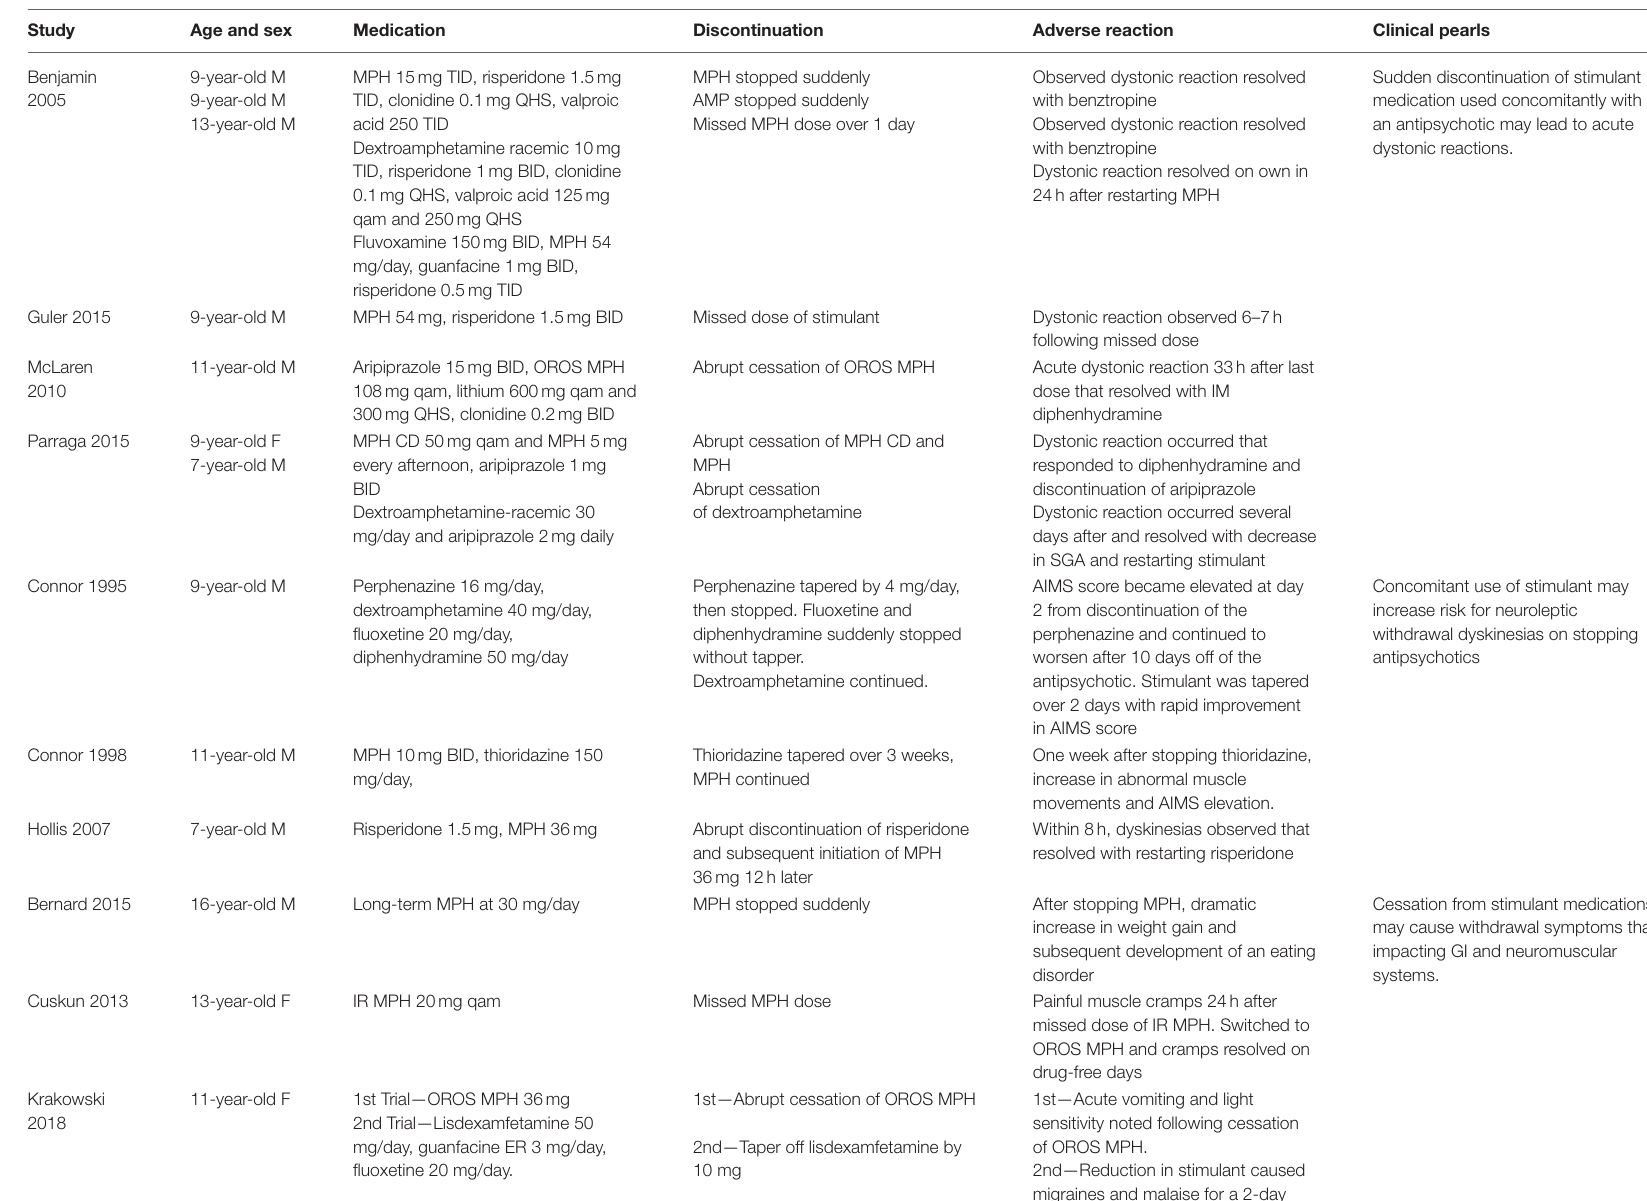
TABLE 3 | Case reports of discontinuation of psychostimulants in children with